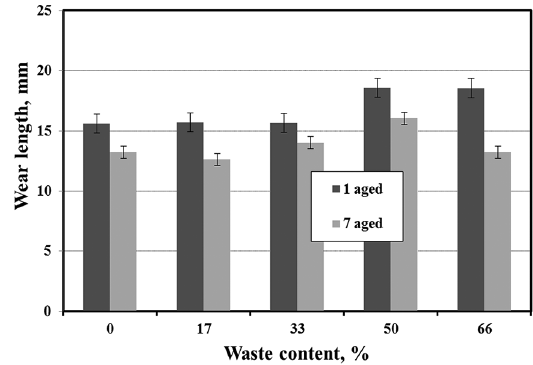
Figure 7. Flexural strength of polymer composite with waste material. Figure 8. Wear resistance of PCBs at different